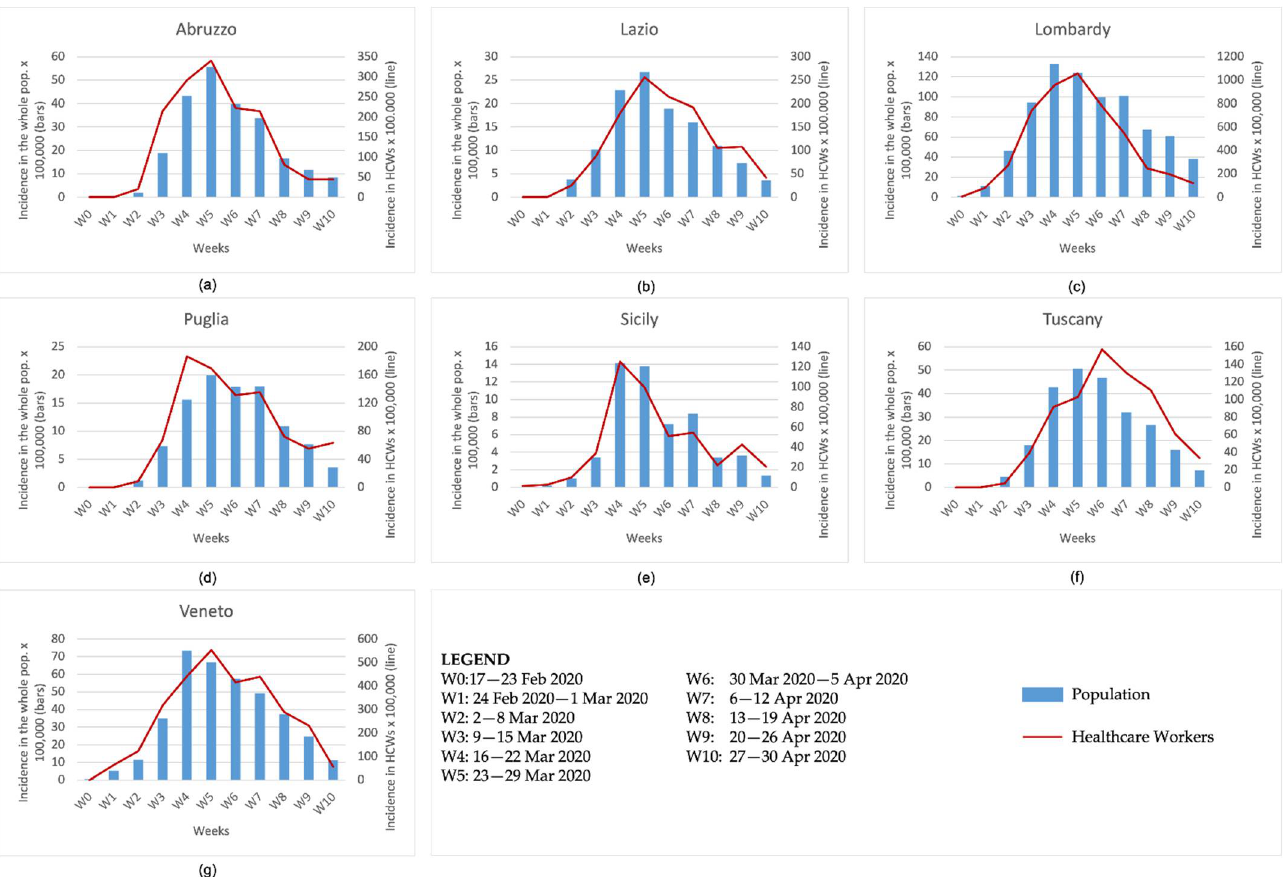
Figure 1. Incidence in the whole population and HCWs by week from the beginning of the pandemic until 30 April 2020 in ( a ) Abruzzo, ( b ) Lazio, ( c ) Lombardy, ( d ) Puglia, ( e ) Sicily, ( f ) Tuscany and ( g ) Veneto.